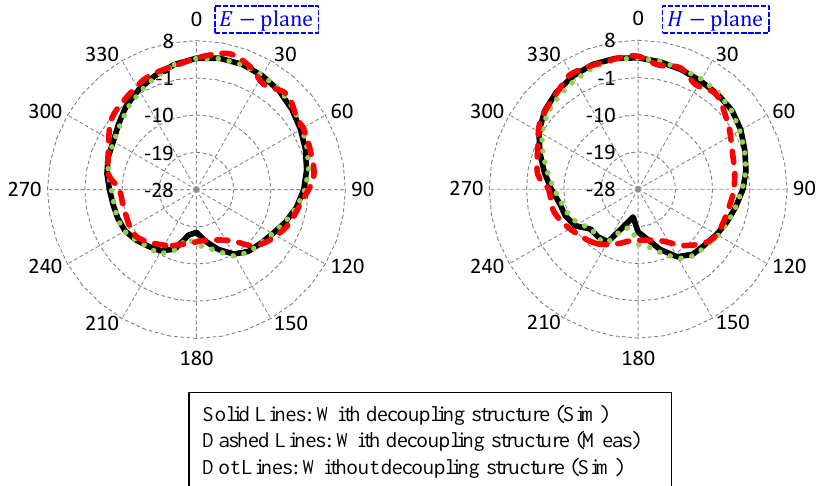
Figure 13. Simulated (with and without decoupling structure) and measured (with decoupling structure) radiation pattern ( E - and H -plane) of the antenna at 5.4